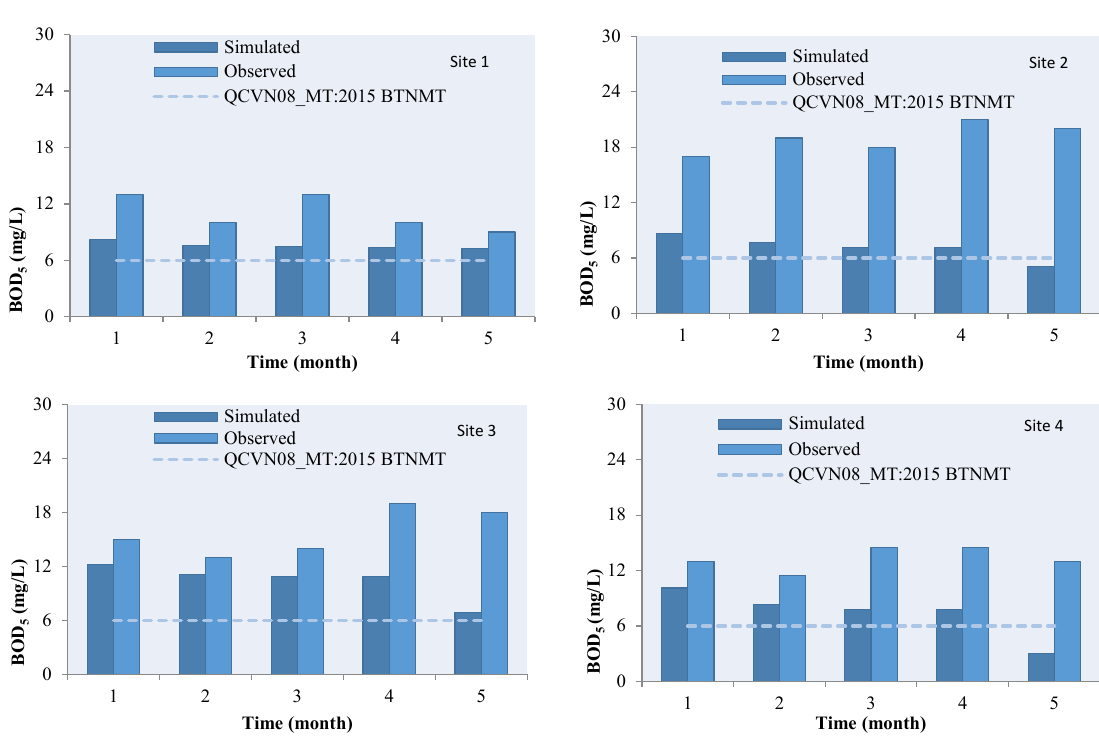
Figure 6. Calibrated results of BOD 5 concentration at the four sites within the study area for the year 2019. The National Technical Regulation on surface water quality (QCVN 08MT:2015) was approved by the Ministry of Environment and Natural Resources (MoNRE) in 2015.